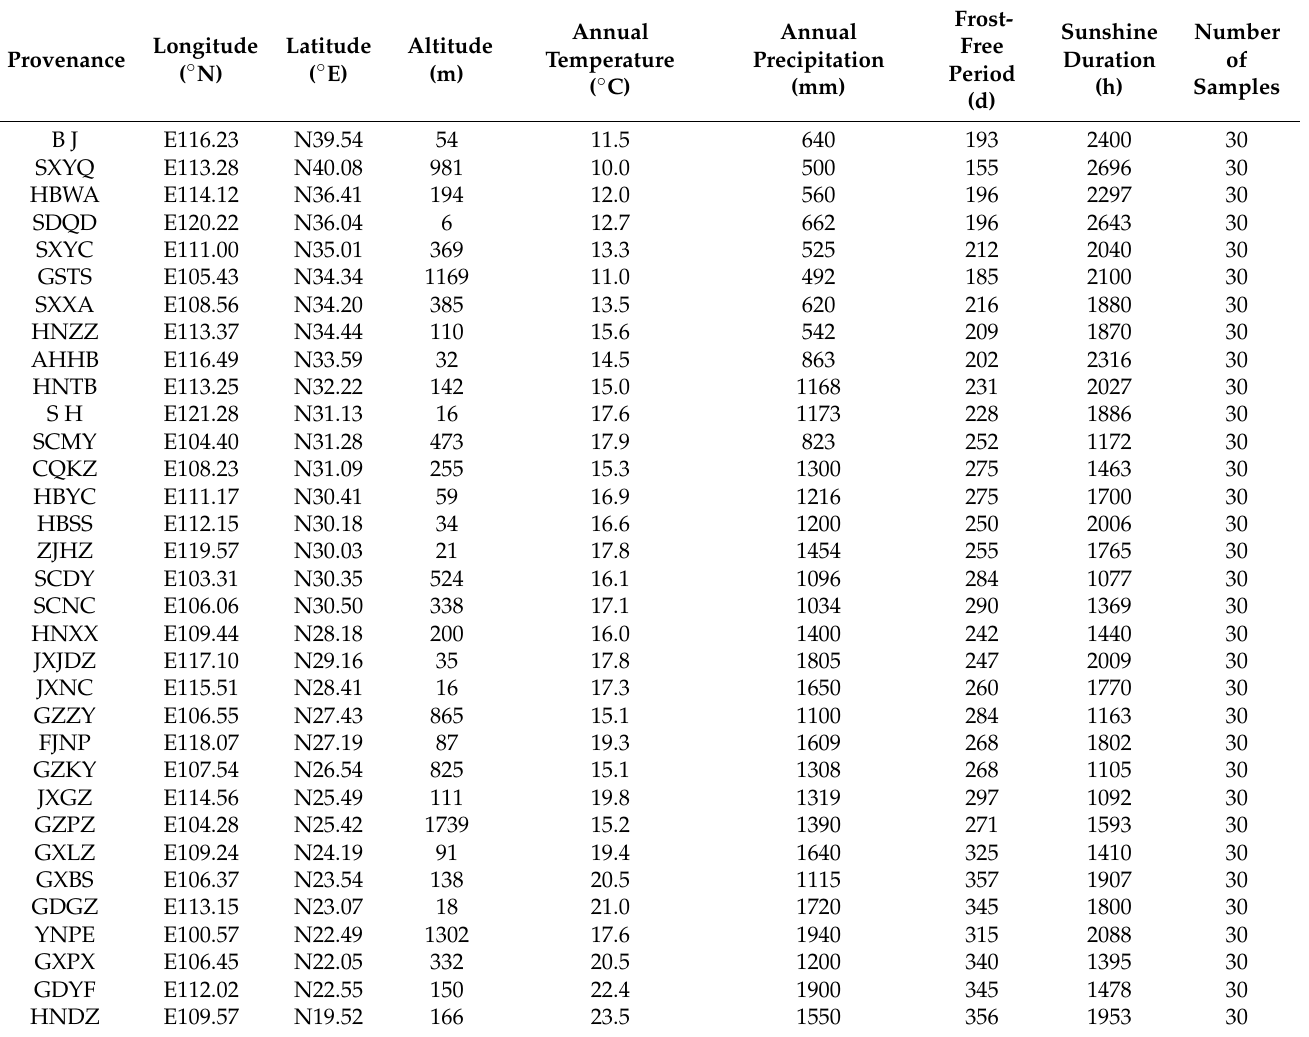
Table 1. Geographic locations and ecological factors of B. papyrifera